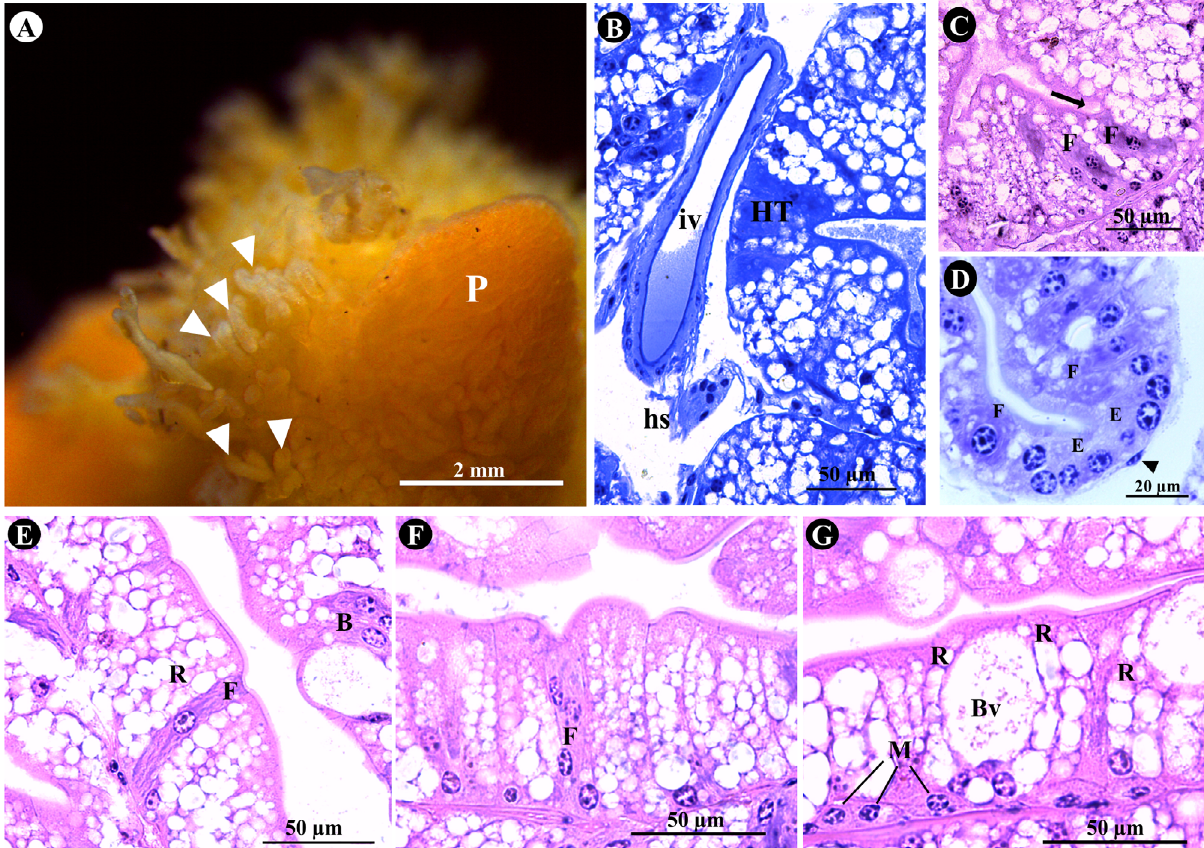
Figure 2. Hepatopancreatic tubules in Macrobrachium carcinus . ( A ) Anatomical detail of a prominence showing the terminal hepatopancreatic tubules (arrowheads). ( B ) Detail of an intra-hepatopancreatic vessel (iv) next to a tubule. ( C ) Transverse section of the hepatopancreatic tubule with F-cells in the region of epithelial infolding (arrow). ( D ) Distal region showing E- and F- cells. Note thick connective tissue involving the tubule represented by the fibroblast nucleus (arrowhead). ( E, F ) Middle region showing columnar F-, R-, and B- cells with small vacuoles in the cytoplasm. ( G ) Proximal region showing R-cells with stacked cytoplasmic vacuoles, B-cells with large cytoplasmic vacuoles, and M-cells in the basal region of the epithelium without lumen contact. Abbreviations: B: B-cells; Bv: B-cells with a large vacuole; E: E-cells; F: F-cells; hs: hemolymphatic space; HT: hepatopancreatic tubule; M: M-cells; P: anatomical prominence; R: R-cells. Staining: toluidine blue ( B, D ) and HE ( C, E, F, G